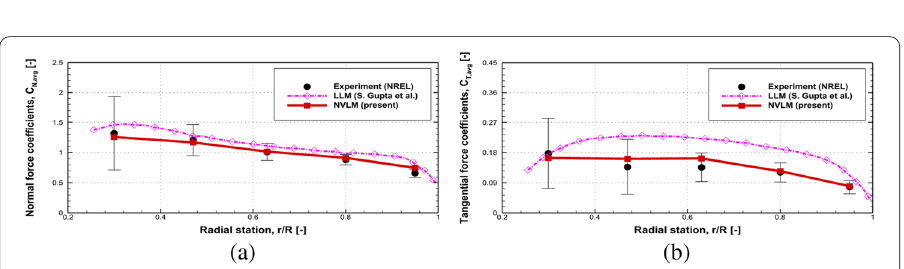
Fig. 18 Comparison of time-averaged force coefficients for V tangential force